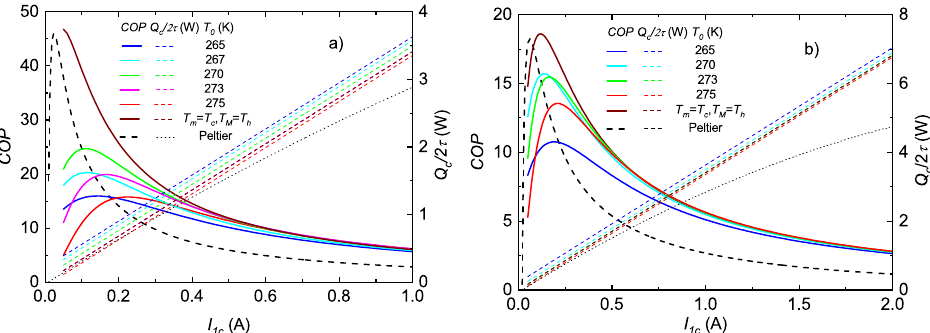
Figure 2. ( a ): COP and cooling power Q c /2 τ of the sandwich vs. current, for T c = 273 K, T h = 275 K, maximum field B = 2 T ( T M = T m + 8 K), and α = 1 (Carnot efficiency of the MC subsystem), for several values of the characteristic temperature T 0 of the MCM. In addition, the data for a pure Peltier system with the same edge temperatures, T c and T h , and equal currents I 1 c = I 2 c . The cooling power is divided by two for comparison, since the hybrid system is extracting heat only for one half of the period. ( b ): Plot for T c = 273 K and T h = 278 K, with the same